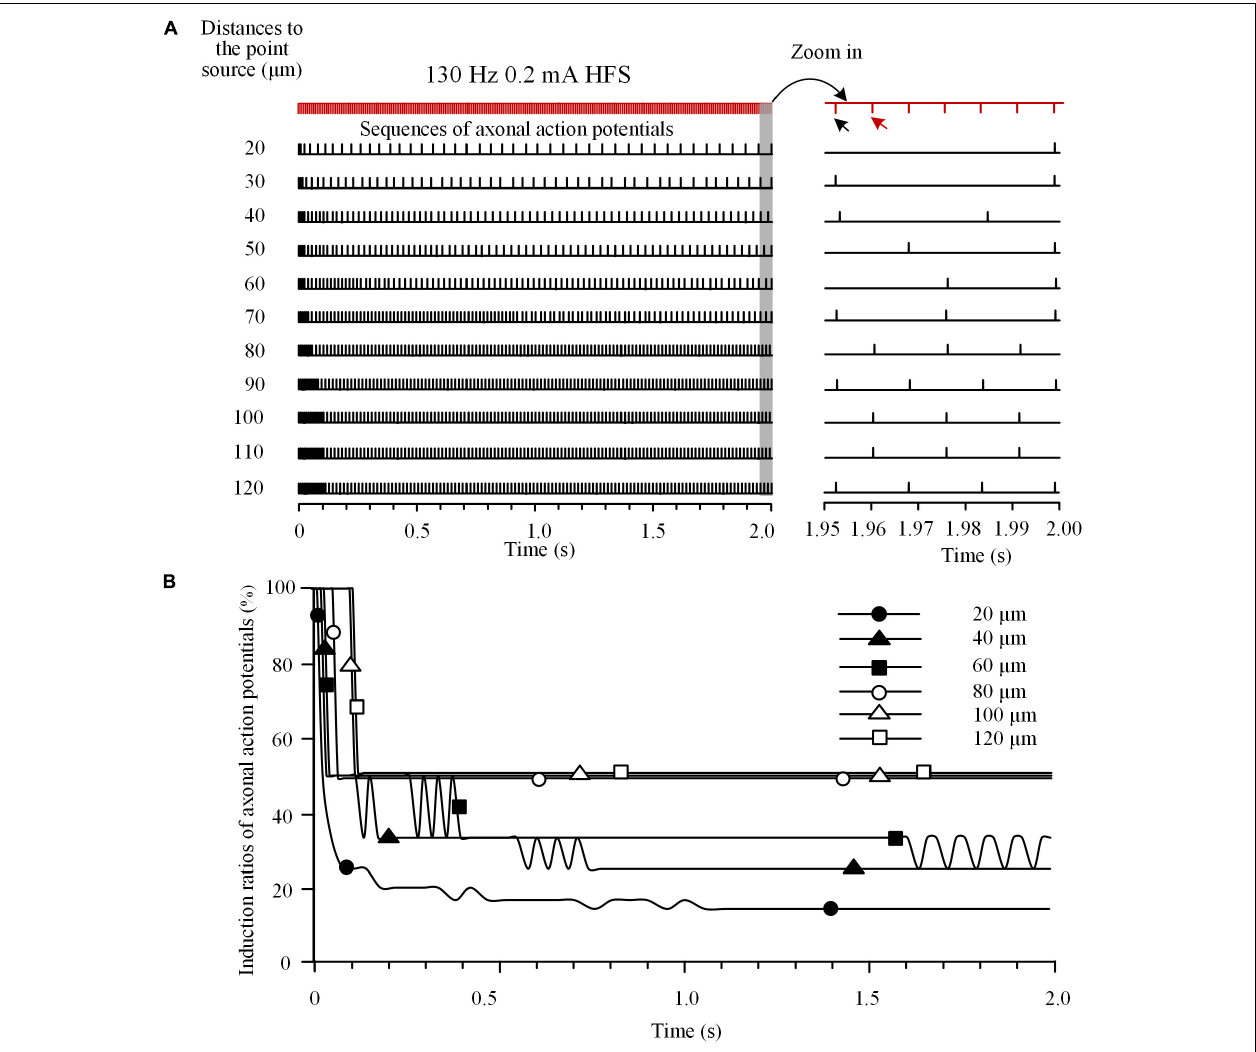
FIGURE 4 | Responses of a bundle of axons to high-frequency stimulation (HFS). (A) Sequences of action potentials generated by 130 Hz HFS (0.2 mA) in 11 axons with different distances to the point source of stimulation. Axonal responses to the last seven pulses at the end of 2-s HFS are expanded at right . (B) Changes of induction ratios of action potentials for the six axons with distances of 20, 40, 60, 80, 100, and 120 µ m to the stimulation source during